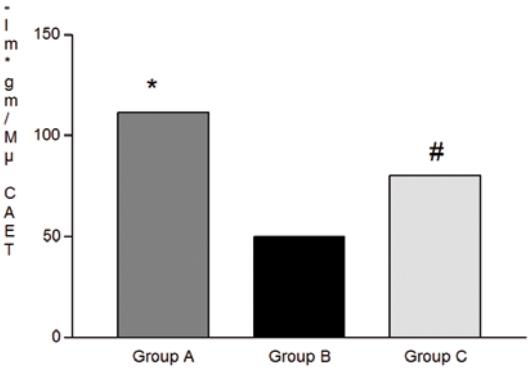
Figure 1 - Mean TEAc values of the samples obtained from the rats, in the different groups.